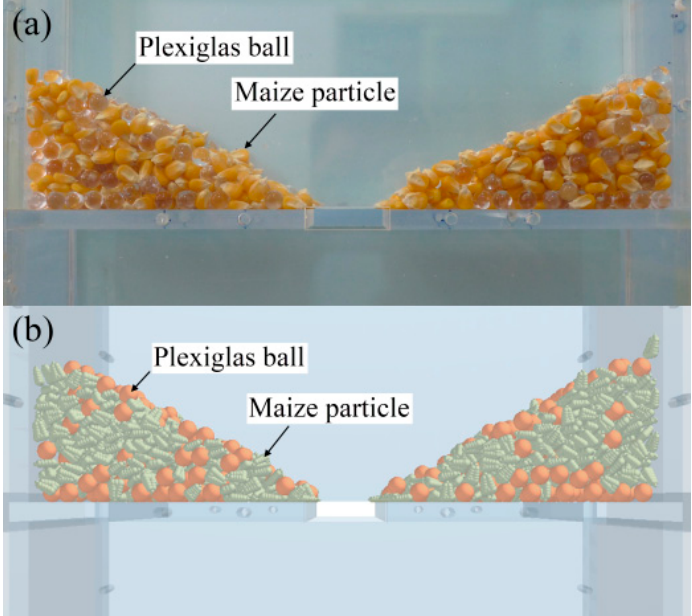
Figure 10. Piling test after mixing maize seeds with organic glass spheres: ( a ) experimental result and ( b ) simulation result.